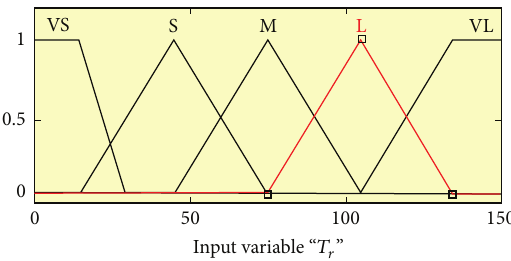
Figure 6: The membership function of output variable 𝑈 𝑟